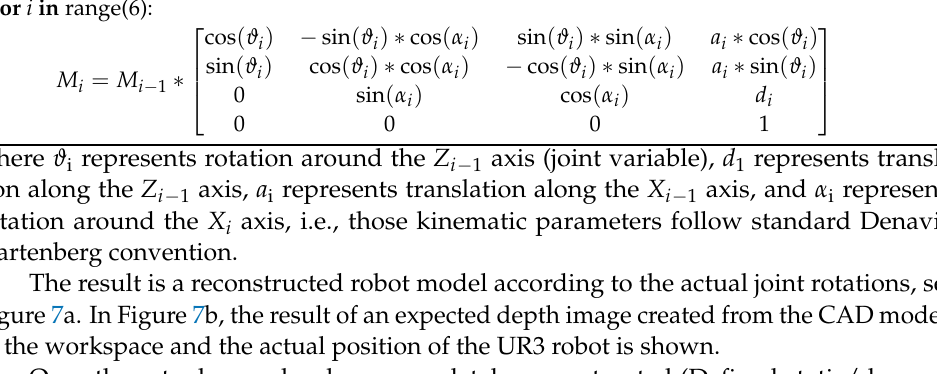
Algorithm 5 Transformation matrix of individual robot elements